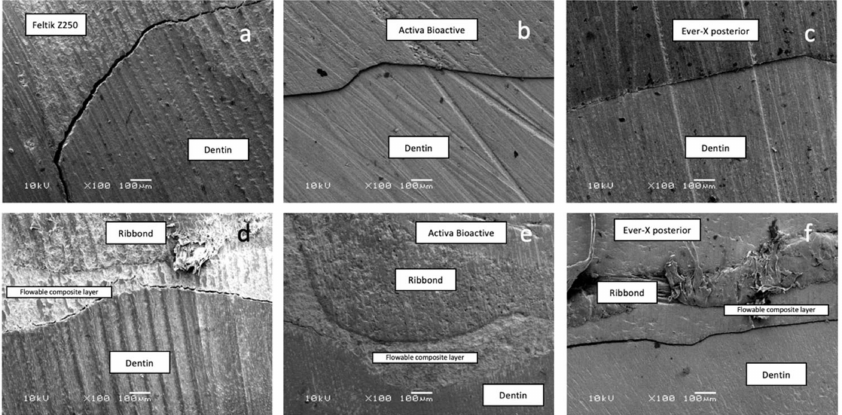
Figure 6. ( a ) Scanning electron image of Group 1. ( b ) Group 2. ( c ) Group 3. ( d ) Group 4. ( e ) Group 5. ( f ) Group